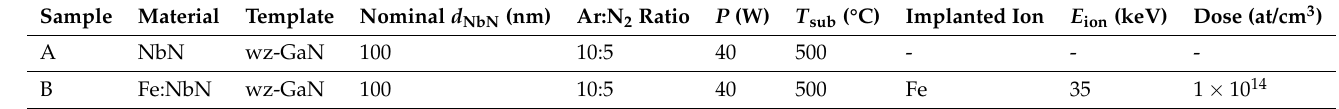
Table 1. Relevant parameters of the representative samples considered in this